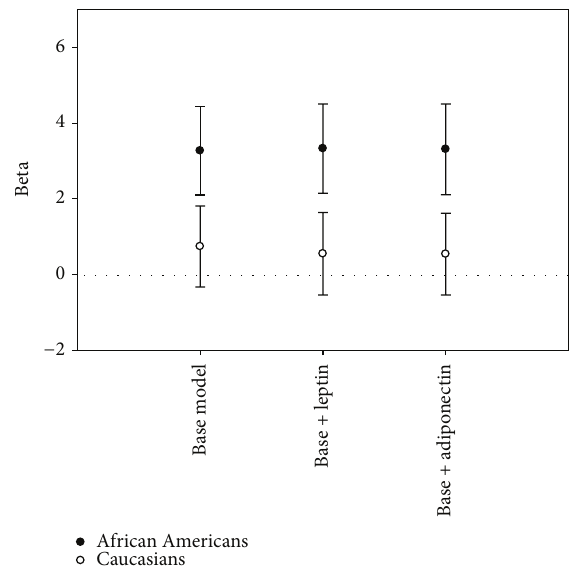
Figure 1: Beta coefficients (95% confidence intervals) for the association between WHR and adenoma stratified on race and adjustedforageandsex,examiningpossiblemediationbyleptinand adiponectin. WHR, leptin, and adiponectin entered as continuous